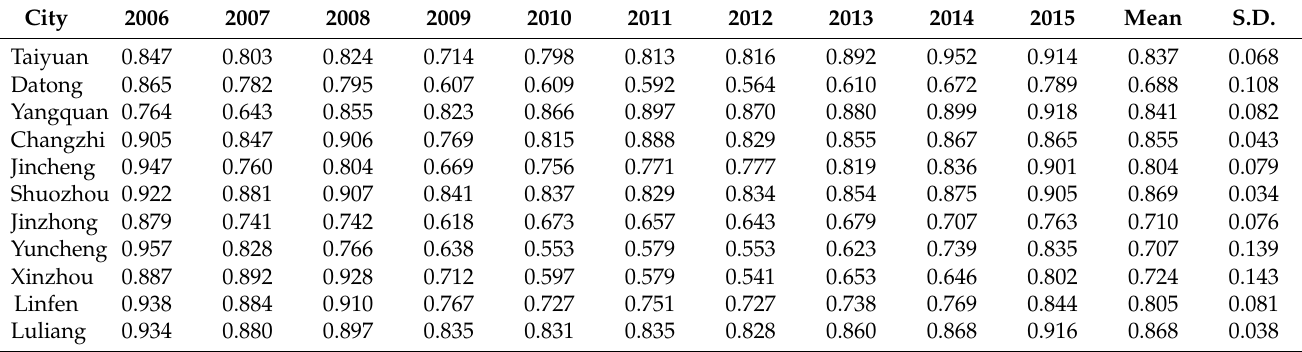
Table 2. The scores of land use efficiencies (Bootstrap-DEA) for 11 prefecture-level cities in Shanxi Province 2006–2015. City